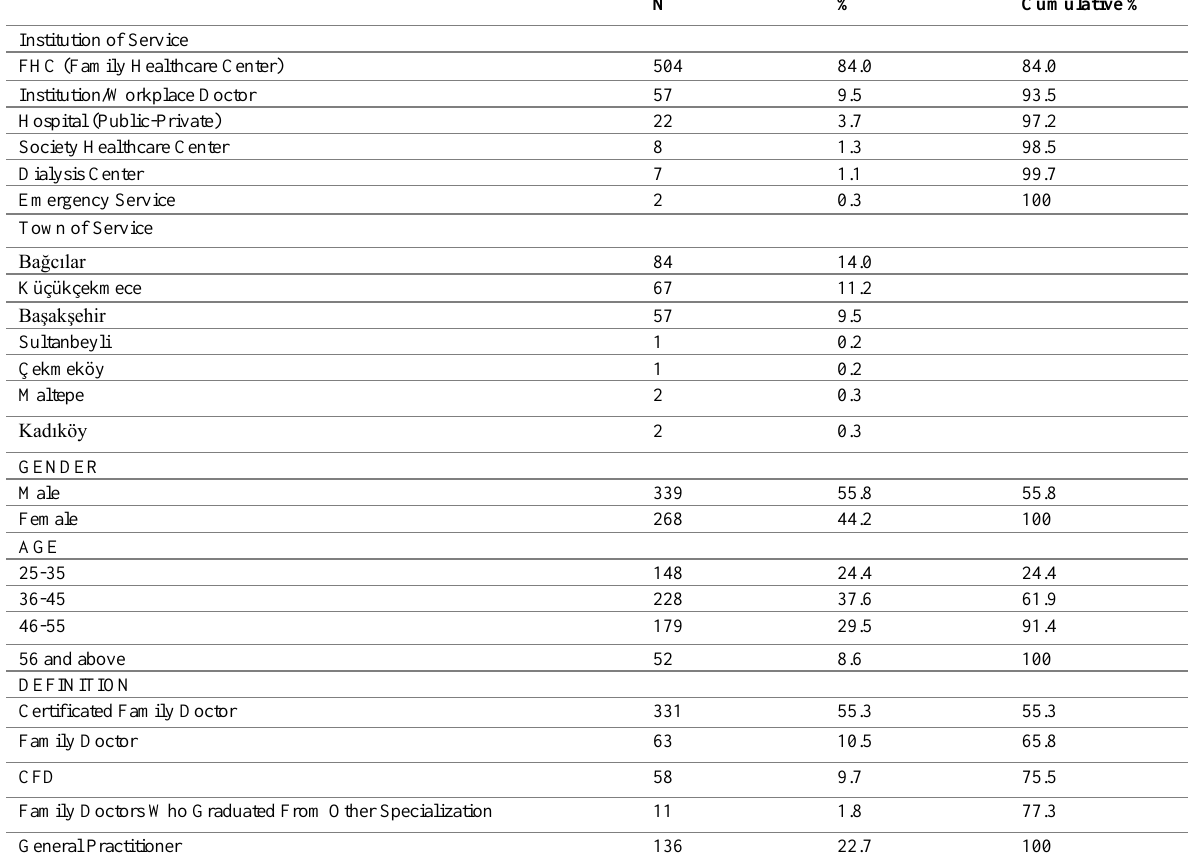
Table 3: General Information of the